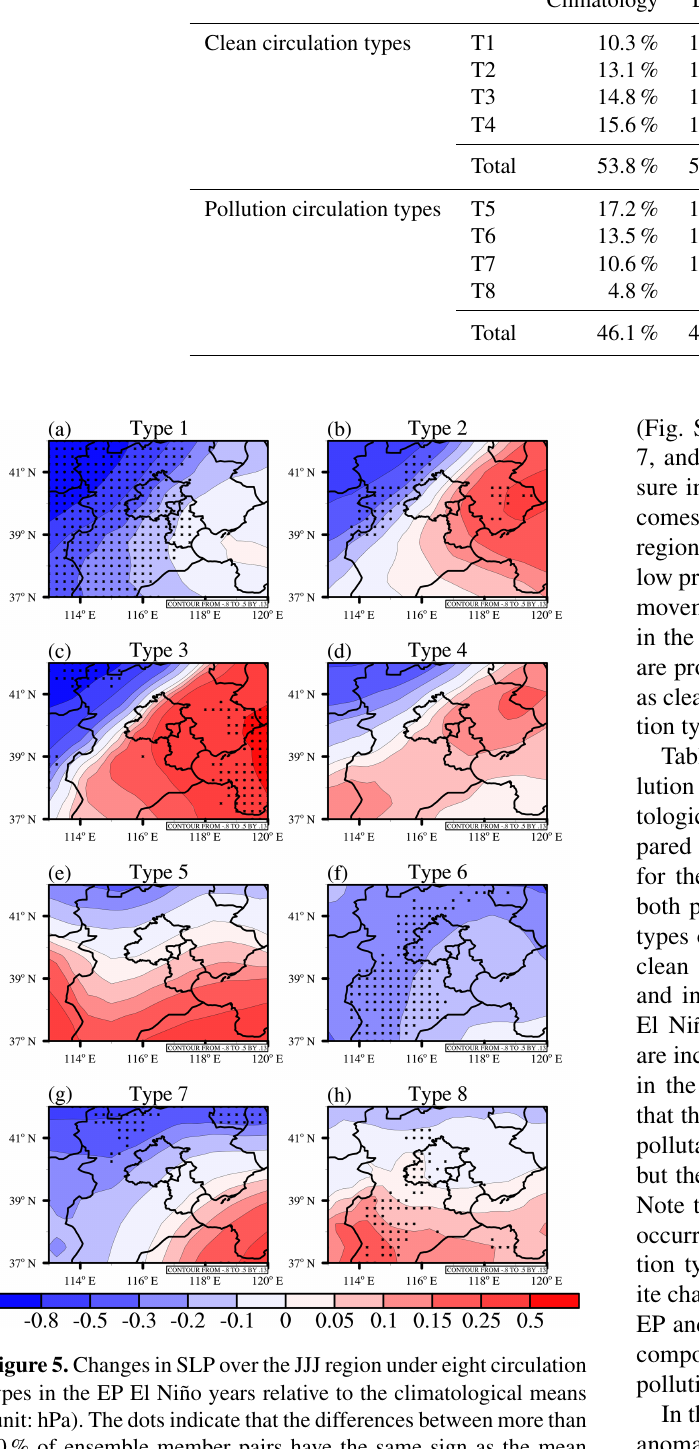
Table 3. The occurrence frequencies of each circulation type in winter for climatology and two types of El Niño years (unit: %). The values in parentheses represent changes relative to the climatological means.